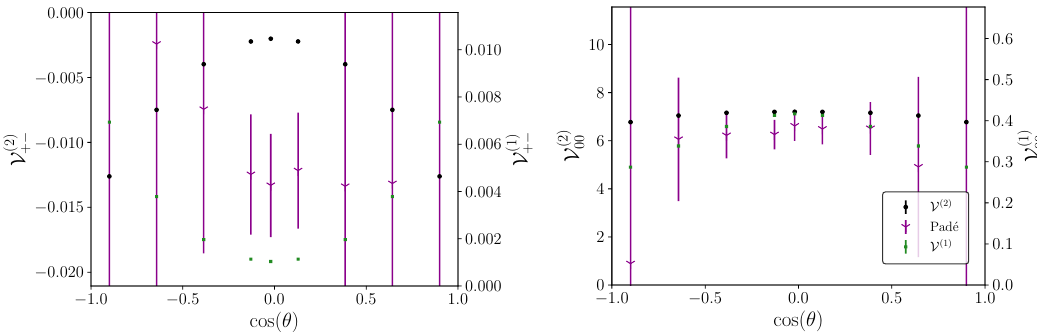
Figure 15. The cos( θ ) dependence of 1-loop and 2-loop interferences for polarised ZZ production √ in gluon fusion at s/m t = 2 . 331 . The Padé improved small top-quark mass expansion [36] is shown for comparison. Here we reproduce the top left and bottom right panels of figure 11 using Catani’s original subtraction scheme [117].